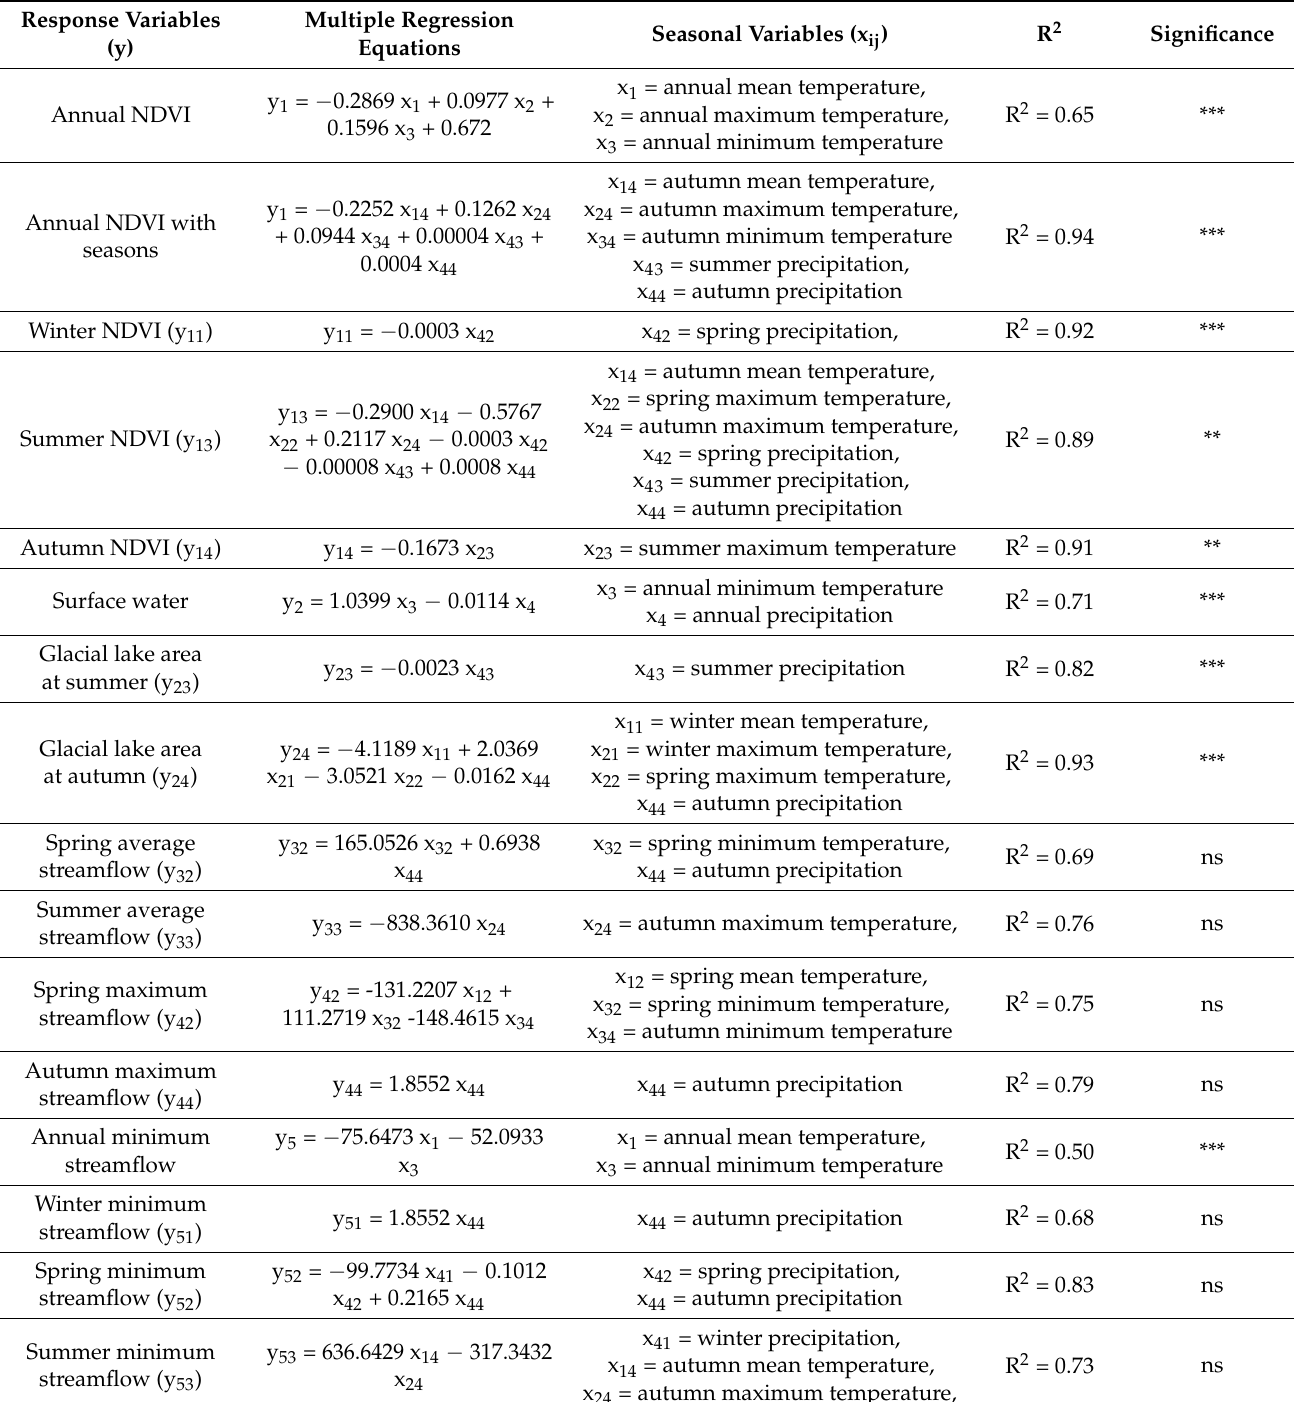
Table 8. Multiple linear regression equations for the relationship between alpine vegetation (NDVI) and surface water (glacial lake plus streamflow) with temperature and